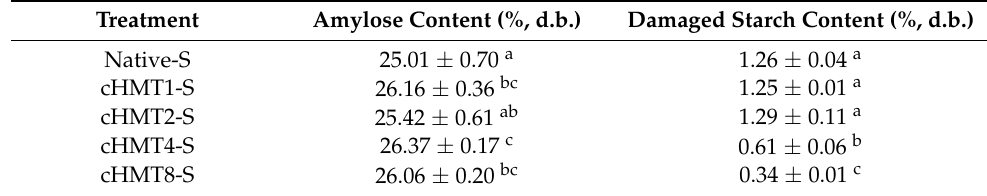
Table 1. Amylose content and damaged starch content of native and cHMT samples 1,2 .